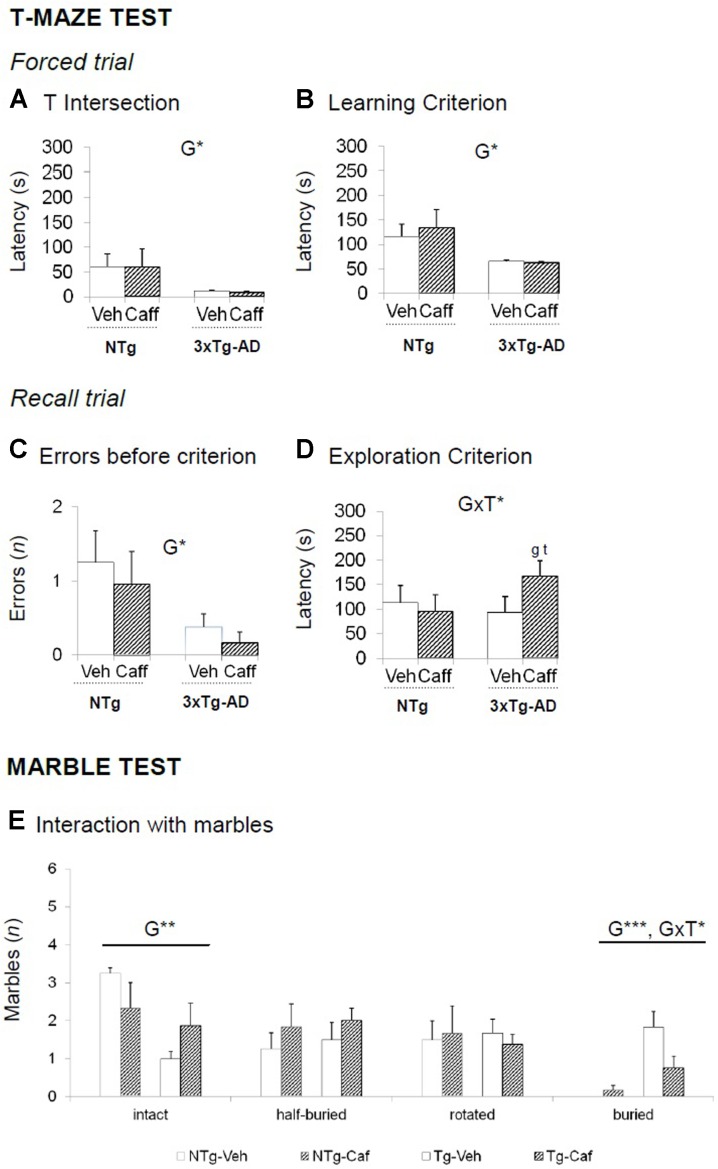
Effects of chronic caffeine treatment assessed in NTg and 3xTg-AD mice at 13 months of age in the T-maze (TM) and marble (MB) tests. (A–E) Behavioral variables (as indicated) of the T-maze test (A–D) and the marble test (E). Data are expressed by mean ± SEM. Veh, vehicle; Caff, caffeine. The text at the top of each graph refers to the p-values of the 2 × 2 ANOVA: G, genotype effect; T, treatment effect: GxT, genotype × treatment interaction; ∗p < 0.05, ∗∗p < 0.01, ∗∗∗p < 0.001. Post hoc comparisons are shown in the graphs as: g p < 0.05, gg p < 0.0l vs. the corresponding NTg group: ∗p < 0.059, ∗∗p < 0.01, ∗∗∗p < 0.001 vs. the corresponding non-treated group.